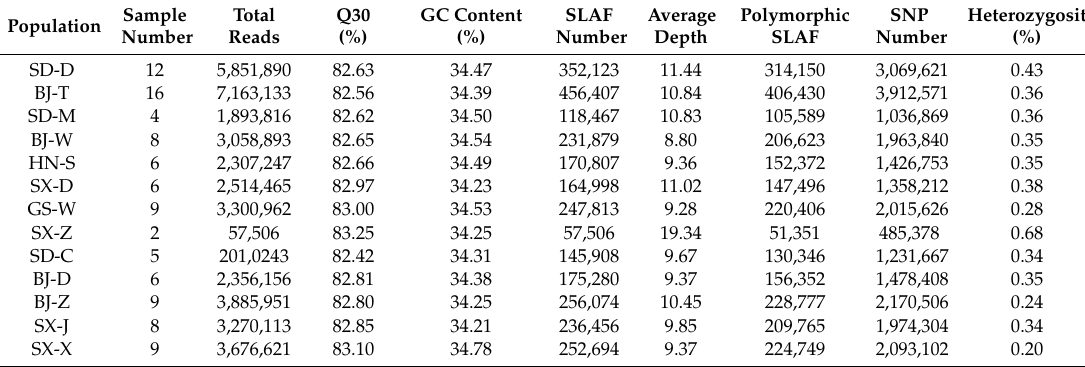
Table 1. Summary statistics for all populations of specific-locus amplified fragment sequencing (SLAF-seq) data processing.